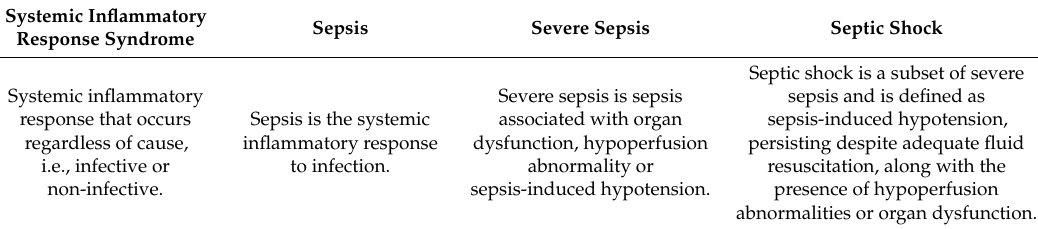
sepsis-induced hypotension.